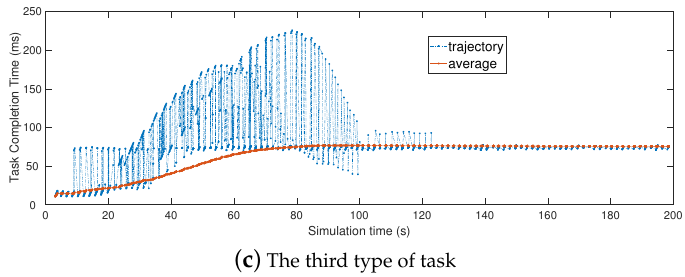
( c ) The third type of task Figure 7. Different types of task completion time in the same region.